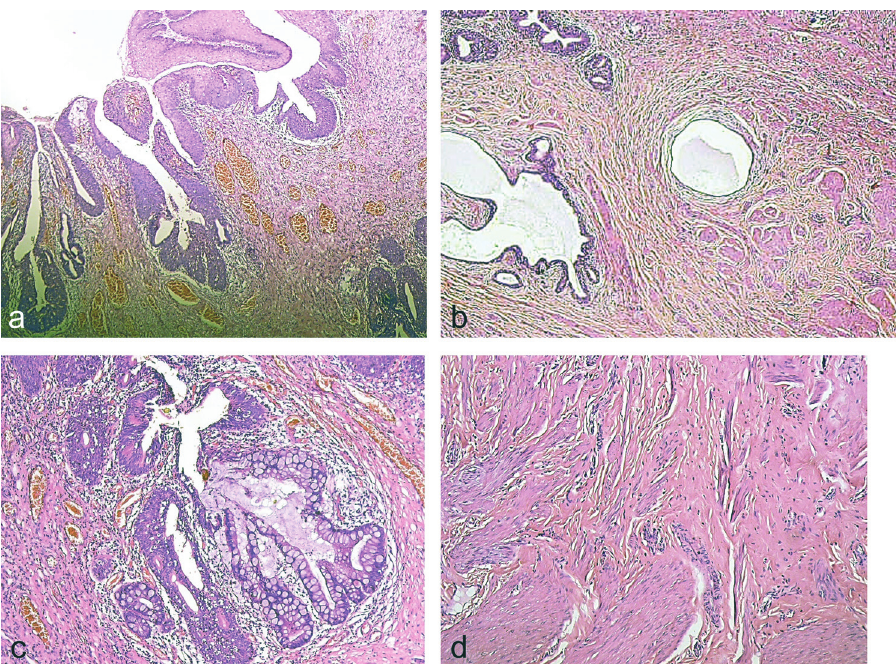
Fig. 3 Histopathological examination of the excised perineal swelling (case 2): ( A ) Polypoid lesion covered by keratinized strati fi ed squamous epithelium with many anal ducts lined by transitional epithelium which are opening on the surface. The core contains multicystic spaces lined by different types of epithelium ( B ), mucin secreting glands, ( C ) with disorganized bundles of smooth muscles in between ( D ). Hematoxylin and eosin; original magni fi cation: a and b ( (cid:1) 40), c ( (cid:1) 100) and d ( (cid:1) 200).